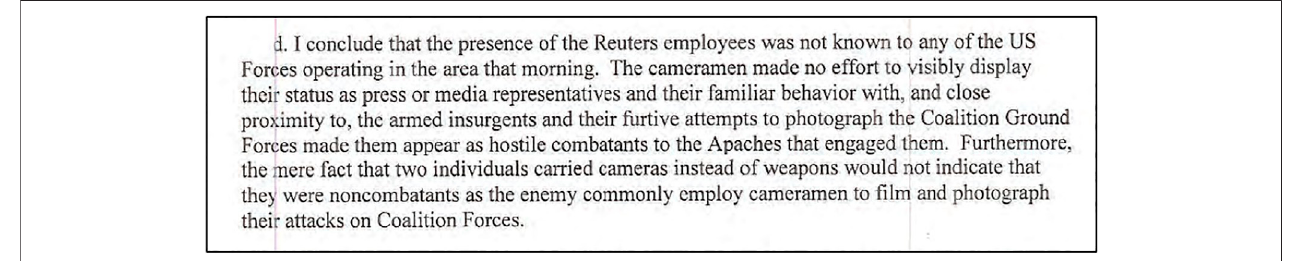
Frontiers in Communication |